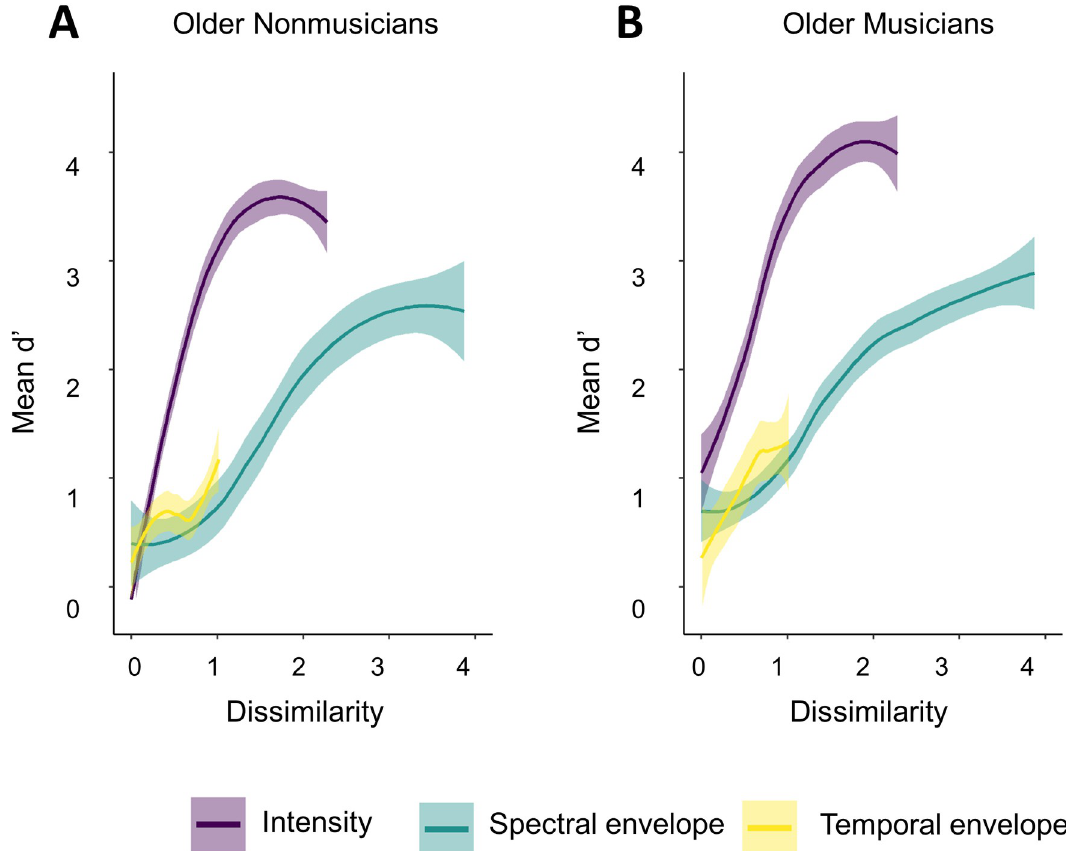
Fig 6. Mean d’ plotted on a common perceptual scale, older adults. Performance plotted against dissimilarity, allowing features to be directly compared for older adults: non-musicians (A) and musicians (B). Standard errors are shown by grey shading around each